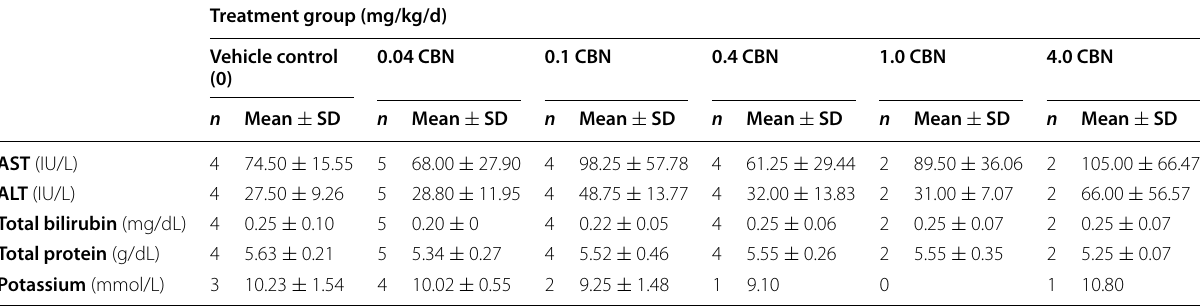
ALT Alanine transferase, AST Aspartate transaminase, CBN Cannabinol, CBNT CBNight ™ , d day, dL deciliter, g gram, IU International units, kg kilogram, L liter, mg milligram, mmol millimole, n number, SD standard